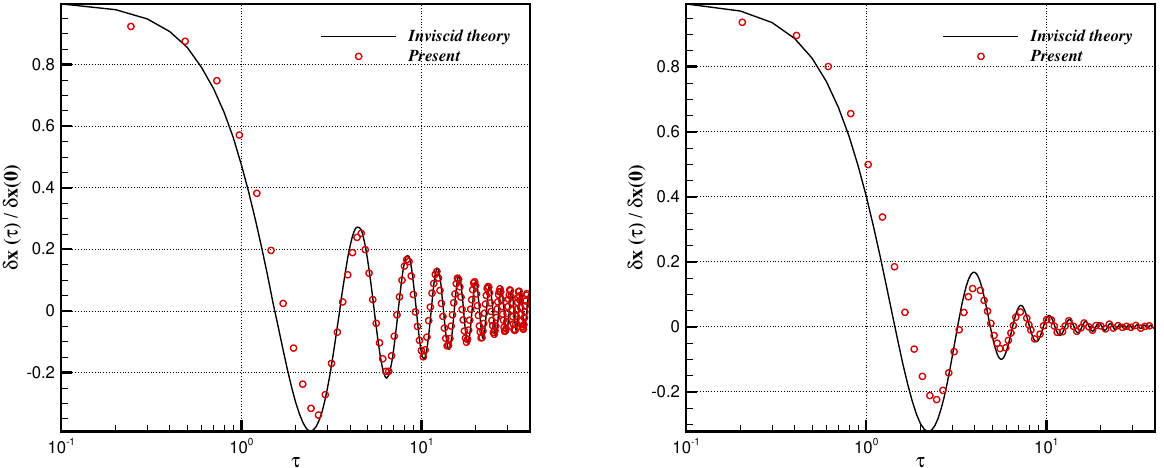
Figure 10. Comparison between the theoretical solution and the simulations for the ripple amplitude of an initially perturbed shock propagating through ( left ) an ideal gas with M 0 = 3.0 ( right ) a van der Waals (vdW) fluid with M 0 =